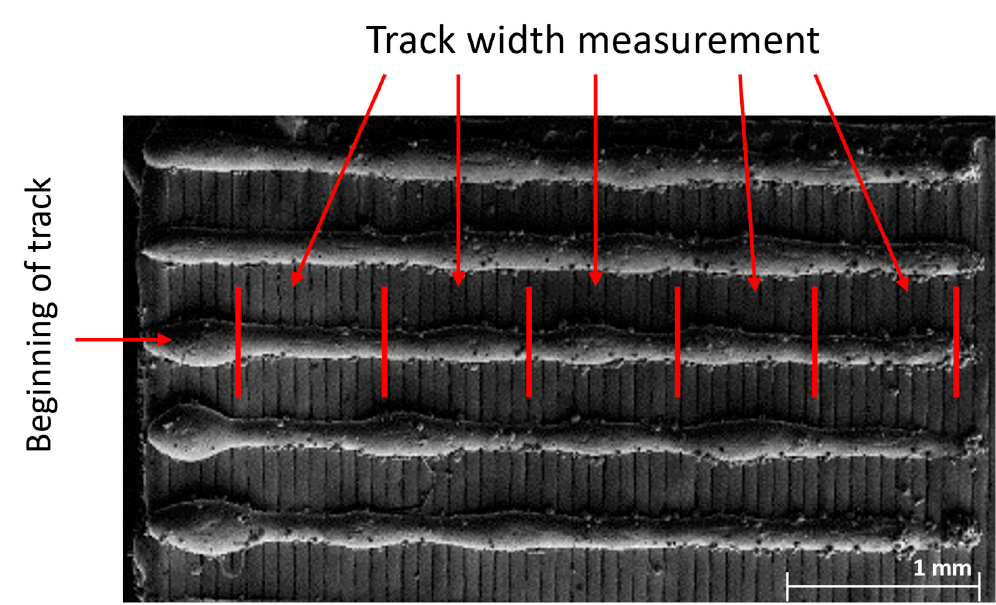
Figure 6. Track average measurement.